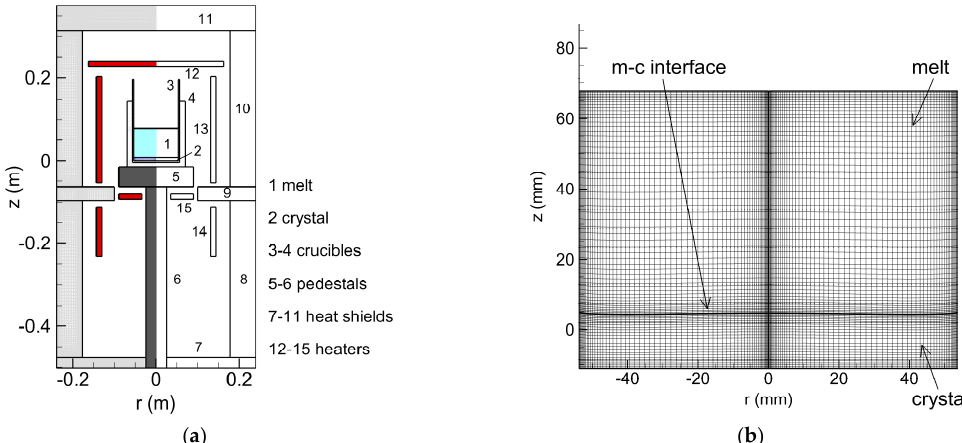
Figure 1. ( a ) Schematic configuration of the directional solidification furnace: melt (1), crystal (2), quartz crucible (3), carbon crucible (4), pedestals (5, 6), heat shields (7–11), heaters (12–15), and ( b ) a local view of the computational grid in the melt–crystal domain.